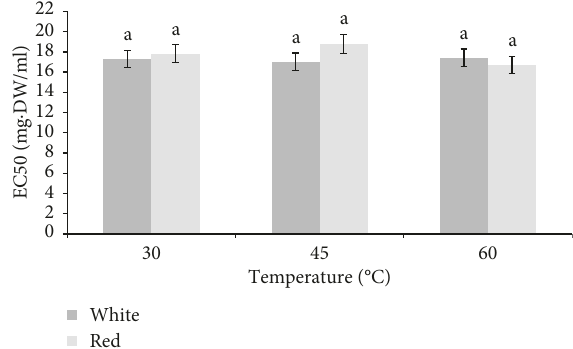
Figure 6: Comparison of free OH radicals scavenging activity of red and white quinoa leaves extracts.